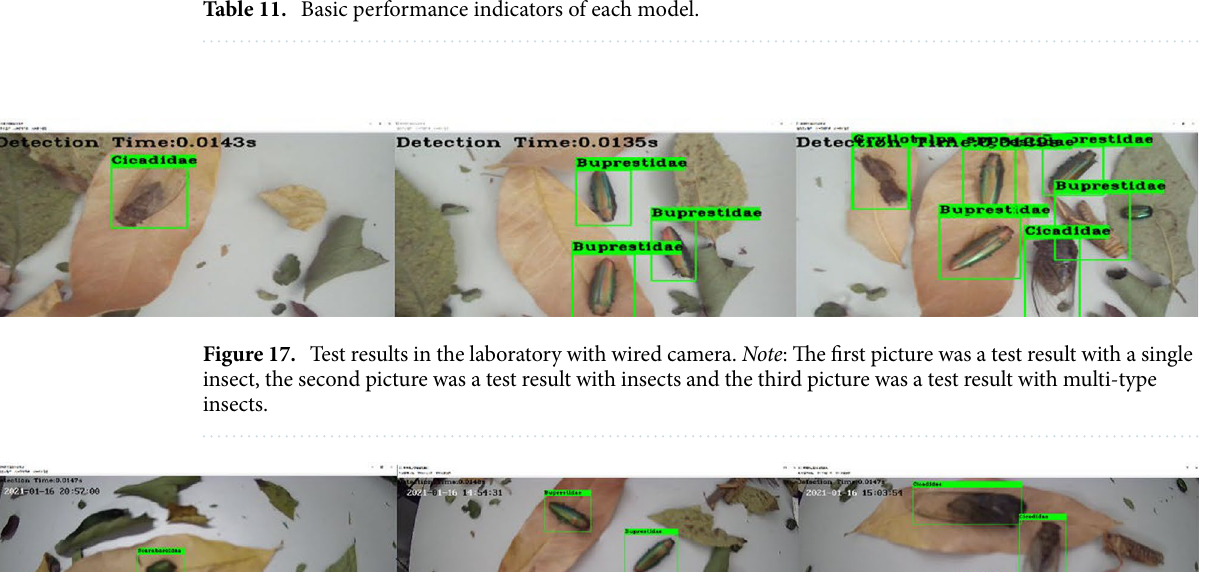
Table 11. Basic performance indicators of each model.